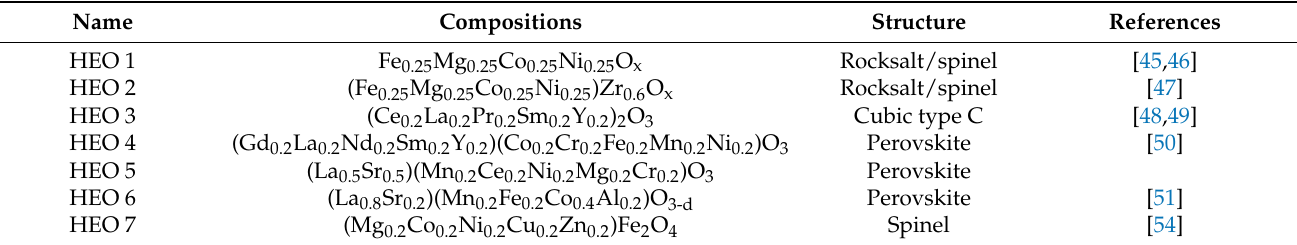
Table 4. List of HEO materials investigated for thermochemical redox